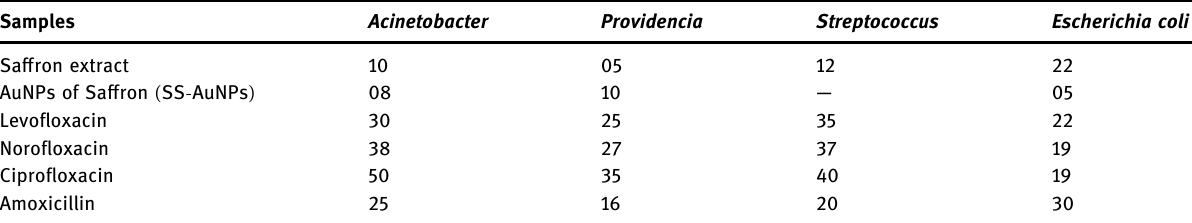
Table 1: Antibacterial e ff ect of sa ff ron extract and AuNPs of sa ff ron ( SS - AuNPs ) ( zone of inhibition in mm )